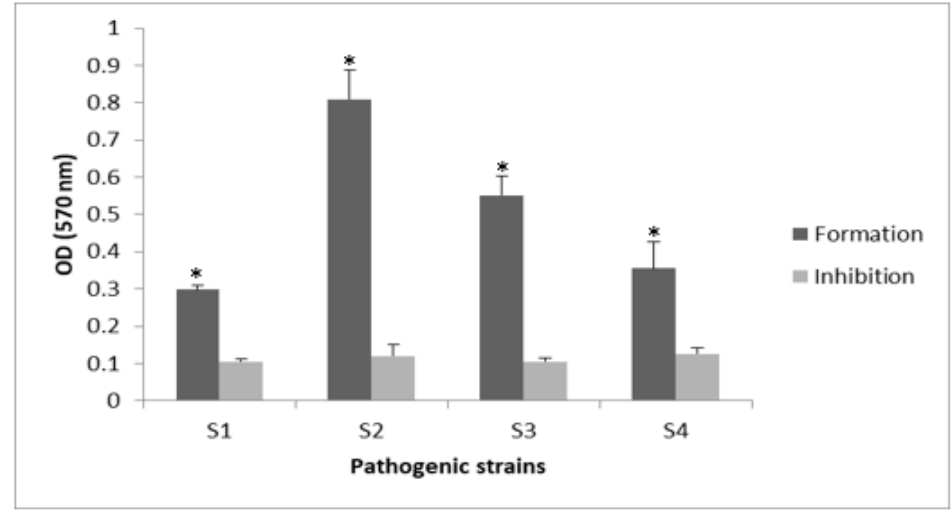
Figure 1. Antibiofilm effect of BioSa3 on S.aureus and S. haemolyticus strains. Formation “without BioSa3” and inhibition “with BioSa3”. S1—MZ475010 ( S. aureus ); S2—MZ475016 ( S. aureus ); S3—MZ474996 ( S. haemolyticus ); S4—MZ475011 ( S. haemolyticus ). * p < 0.05.